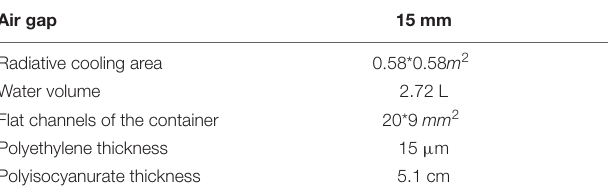
TABLE 1 | Dimensions of the system